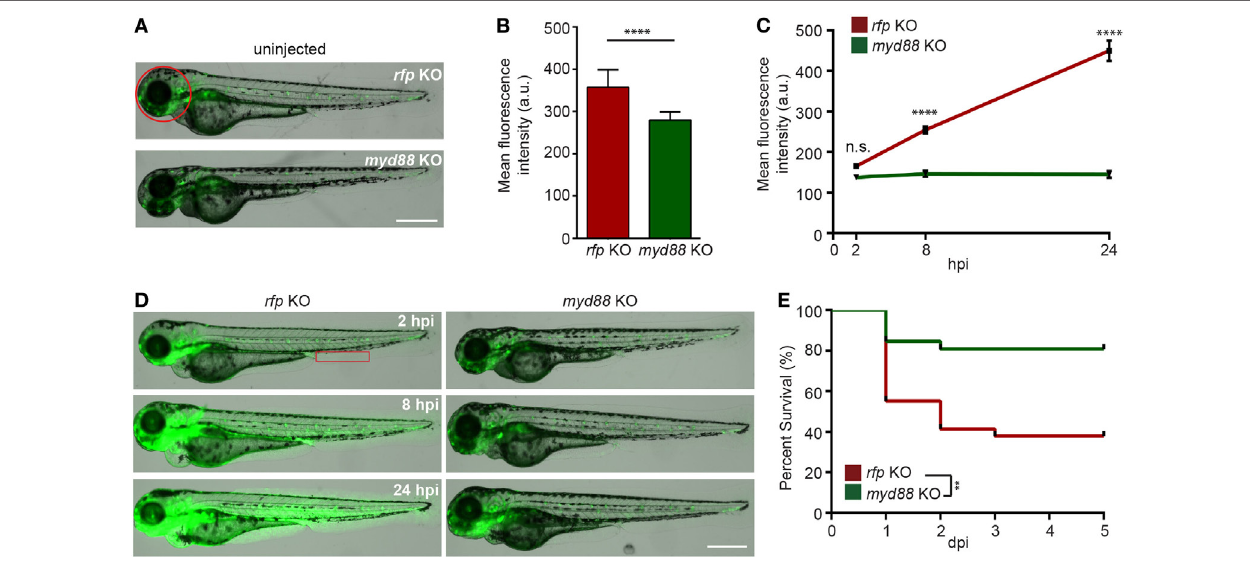
FigUre 5 | Knockout of MyD88 dampens NF- κ B activation and reduced mortality in the zebra fish endotoxemia model. Zebra fish embryos of Tg(NF: κ B:GFP) were injected with sgRNA against myd88 or rfp at the single-cell stage. (a,B) Representative images (a) and quantification (B) of the GFP intensity in the head (red circle) of uninjected 3dpf larvae. Scale bar: 500 µm. Results are presented as mean ± SD ( n = 3 independent experiments with over 20 larvae each/experiment). **** p < 0.0001, Mann–Whitney test. (c,D) myd88 or rfp KO larvae were injected with LPS. Quantification of NF- κ B activity (c) and representative images (D) of the GFP intensity in the Tg(NF κ B:GFP) background in the indicated region (red box). Scale bar: 500 µm. Results are presented as mean ± SD ( n = 3 independent experiments with over 20 larvae each/experiment). **** p < 0.0001, Kruskal–Wallis test. (e) Survival curve of myd88 or rpf KO larvae injected with LPS. One representative experiment of three independent biological repeats ( n = 20 each group) is shown. ** p < 0.01 , Gehan–Breslow–Wilcoxon